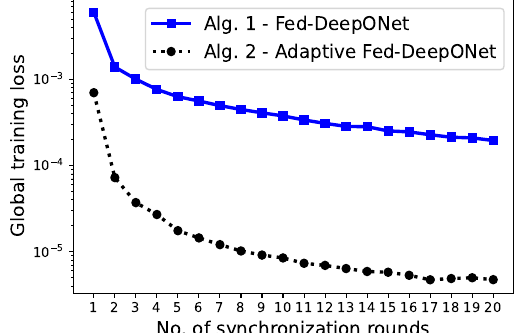
Figure 2. A comparison of the federated training convergence between Fed-DeepONet (Algorithm 1) and Adaptive Fed-DeepONet (Algorithm 2). We used an idealistic federated scenario with C = 20 clients with a fraction α = 0.75 of available clients, R = 20 global synchronization rounds, and K = 200 local